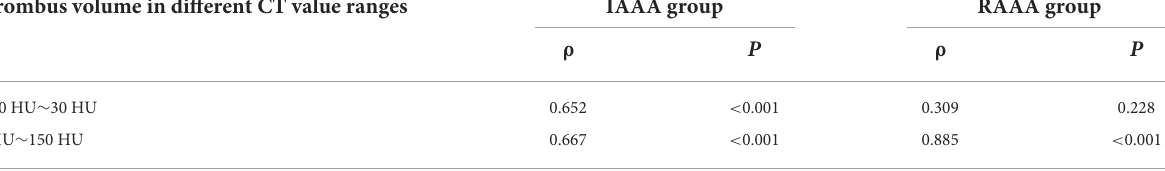
TABLE 6 Correlation between thrombus volume in different CT value ranges and standardized